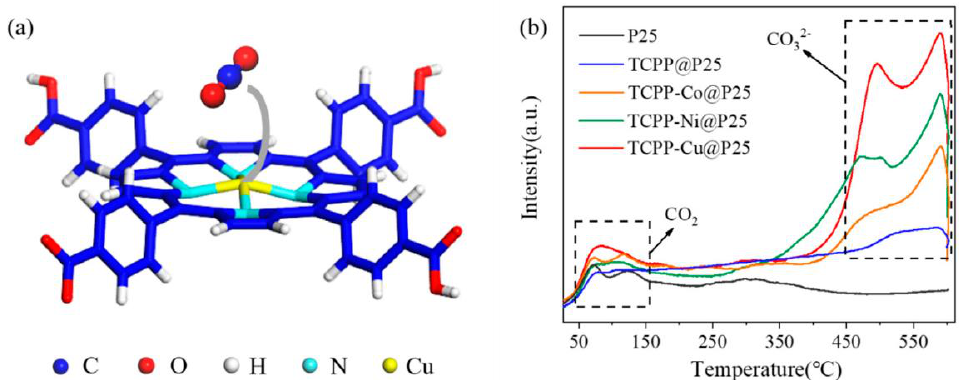
Figure 5. ( a ) Optimized structure for CO 2 adsorption on a TCPP-Cu unit; ( b ) CO 2 -TPD spectra of P25, TCPP@P25, TCPP-Co@P25, TCPP-Ni@P25 and TCPP-Cu@P25. Reproduced from reference [57]